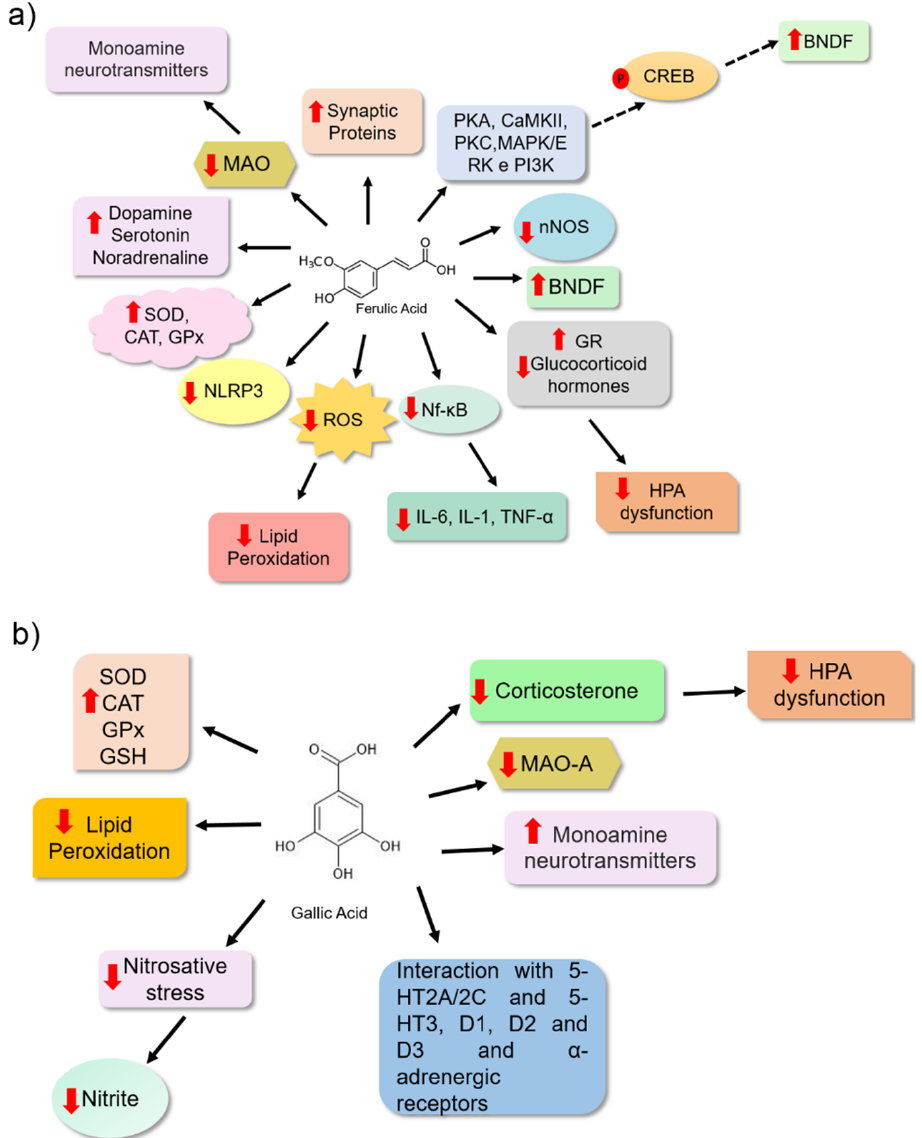
Figure 4. Possible mechanisms of action for ferulic acid ( a ) and gallic acid ( b ) as antidepressants based on preclinical trials. ( a ) Ferulic acid may act by inhibiting MAO-A enzyme activity by increasing levels of endogenous antioxidants, combating lipid peroxidation, inhibiting neuroinflammation, and the hyperactivity of the hypothalamic–pituitary–adrenal (HPA) axis, and increasing levels of brain- derived neurotrophic factor (BDNF) and synaptic plasticity. ( b ) The antidepressant effects of gallic acid are mainly caused by its antioxidant potential because this promotes the activity of antioxidant enzymes, such as SOD, CAT, and GPx, and increases the content of endogenous antioxidants, such as GSH. The compound also inhibits lipid peroxidation and reduces nitrite levels, demonstrating its action against oxidative and nitrosative stress. Additionally, gallic acid may promote the regulation of the hypothalamic–pituitary–adrenal (HPA) axis because it can reduce elevated corticosterone levels. Its effect is also associated with increased serotonin noradrenaline and dopamine levels in the synaptic cleft. These bioactive molecules may interact with alpha-adrenergic, dopaminergic, and serotoninergic receptors to promote their antidepressant effects. Arrows in red (up) indicate increased levels and (down) reduced levels. The solid black arrow indicates stimulation, and the dashed black arrow indicates possible activation (a mechanism not directly evaluated in the study). The chemical structures were drawn using ChemSketch freeware, version 14.0 from